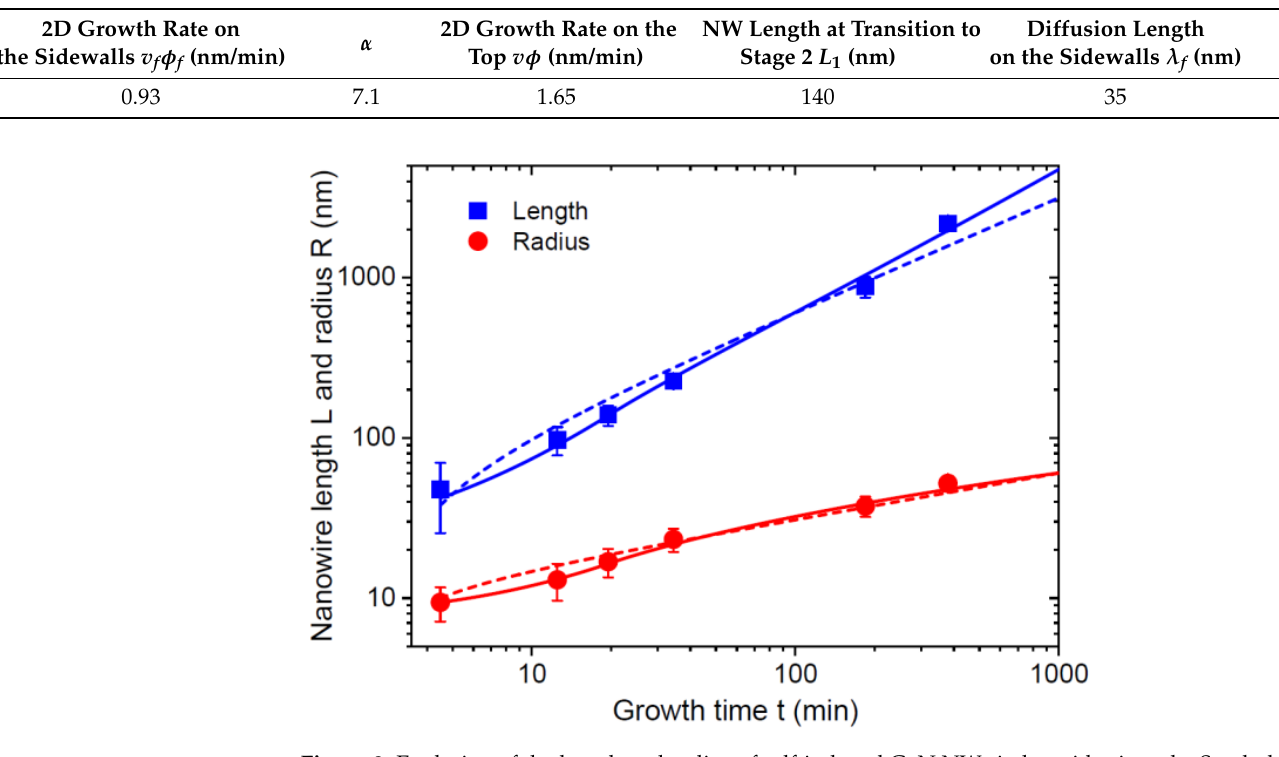
Figure 8. Evolution of the length and radius of self-induced GaN NWs in logarithmic scale. Symbols represent the data from Ref. [42]. The dashed lines are the fits by the scaling power-law model from Ref. [42]. The solid lines are the fits obtained within the modified model.